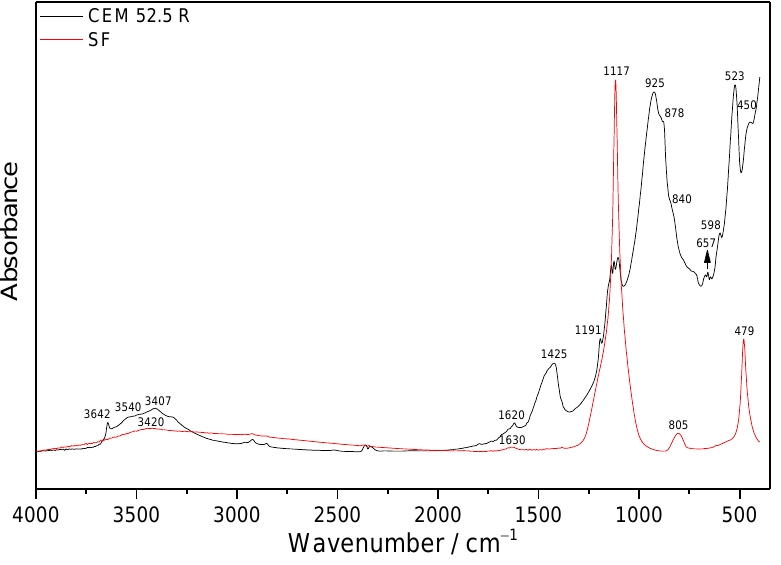
Figure 1. The MIR spectra of initial materials.